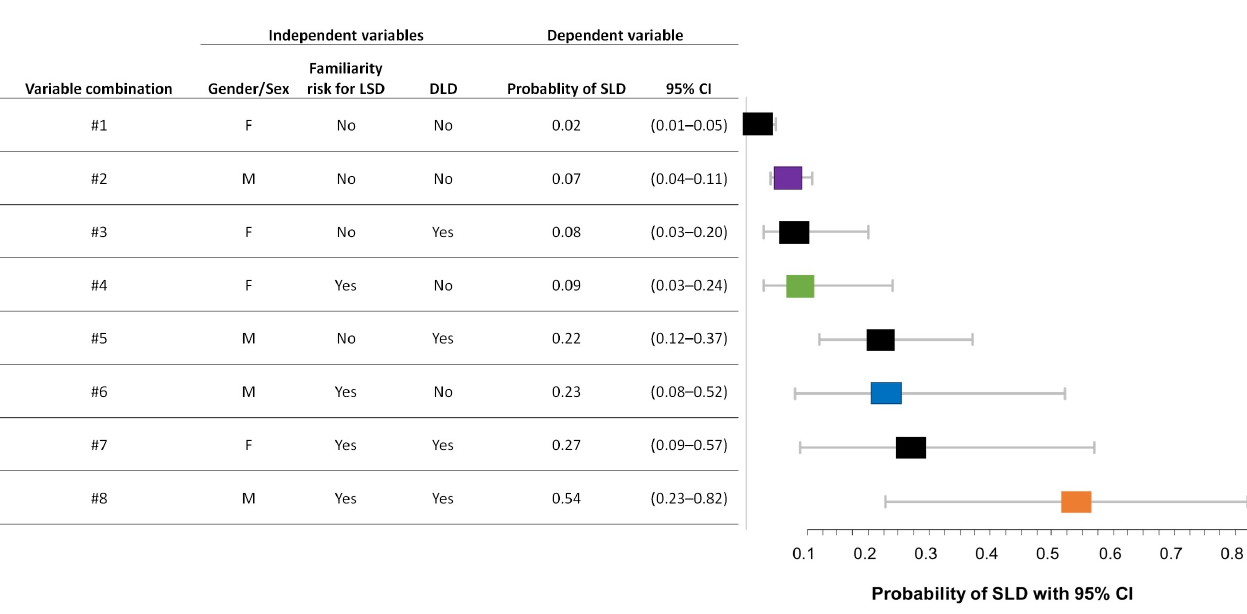
Figure 2. Probability to receive a diagnosis of SLD associated with the possible combinations among the different levels of the variables entered in the best multivariable model. Table 4. Details of the univariable analyses and the best multivariable model with diagnosis of DLD as the dependent